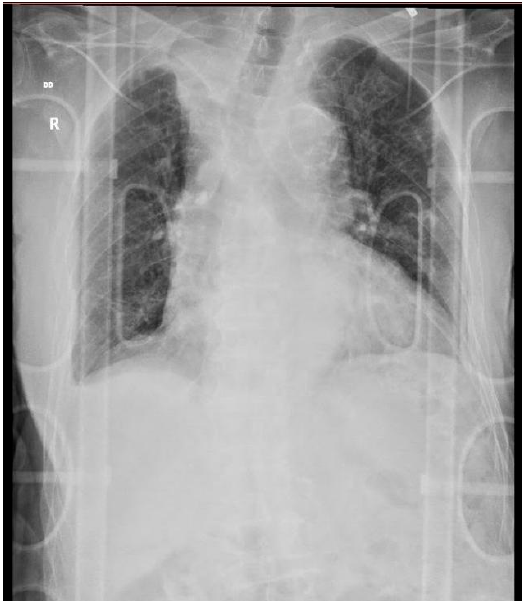
Figure 5. Chest X-ray upon arrival as per pre-surgery protocol, anteroposterior incidence. Description: diffuse, bilateral, reticular pattern. Possible right upper lobe atelectasis. Increased area of projection of the heart and mediastinum. Minimal right pleural effusion. No signs of rib fractures.